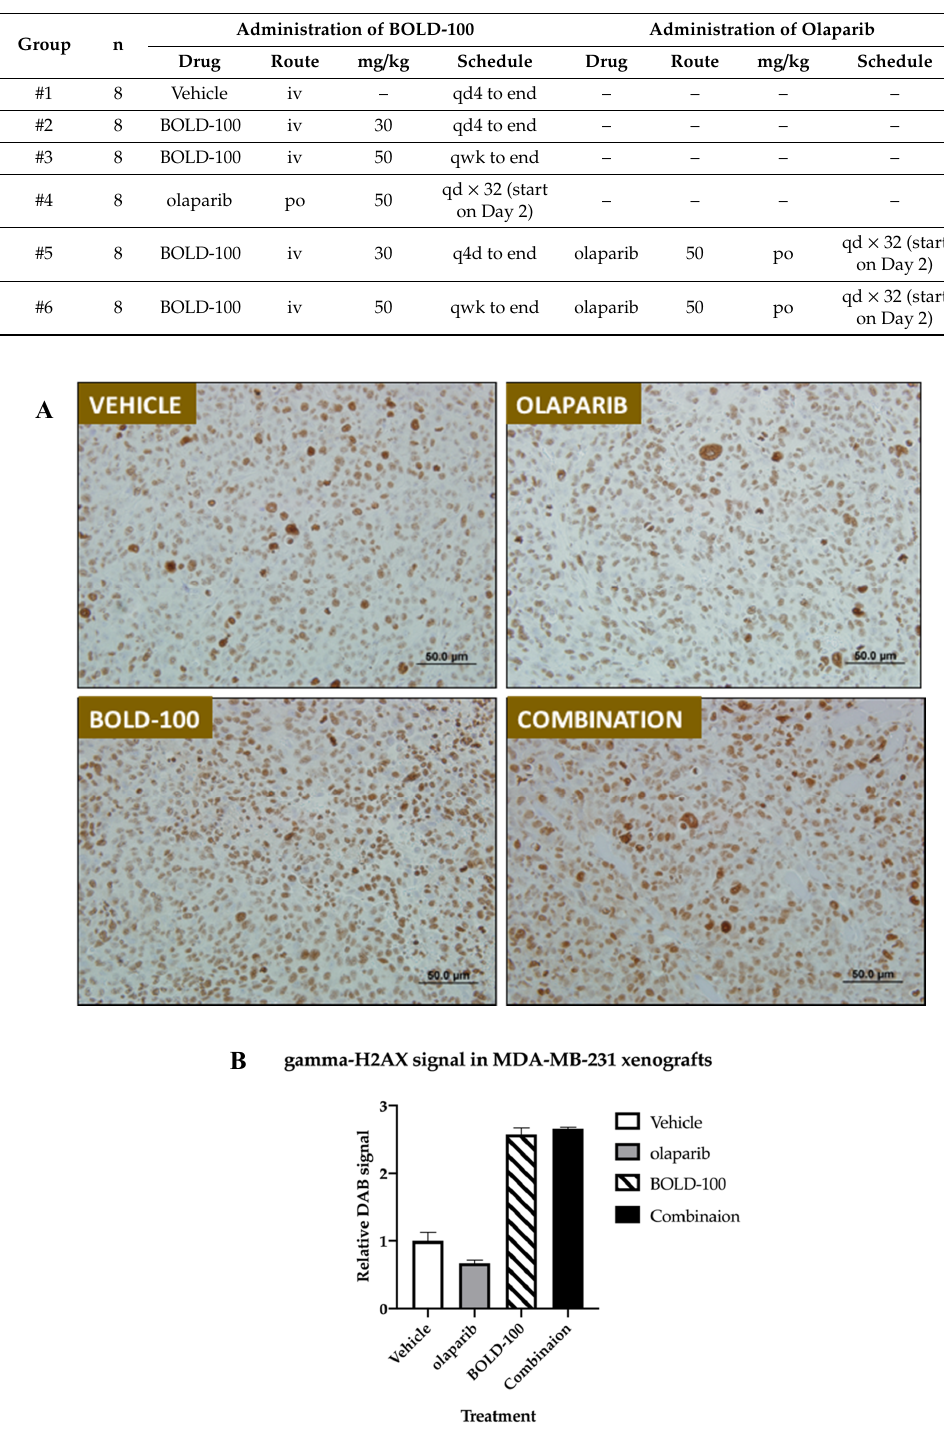
Figure 8. Treatment with BOLD-100 or BOLD-100+olaparib increased gamma-H2AX protein levels in MDA-MB-231 xenografts. (A) Immunohistochemical (IHC) gamma-H2AX staining show increased protein levels (diaminobenzidine (DAB), brown) in tumors treated with BOLD-100 (50 mg/kg) or BOLD-100 (50 mg/kg)+olaparib compared with vehicle or olaparib only treated tumors. ( B ) Semi-quantitative analysis of DAB signal (see Section 4.9) shows increased gamma-H2AX in tumors treated with BOLD-100 compared with control.